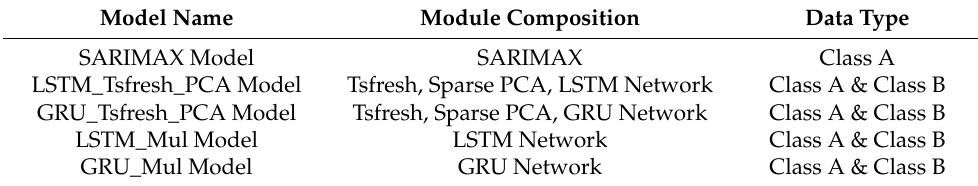
Table 4. The module composition of the different prediction